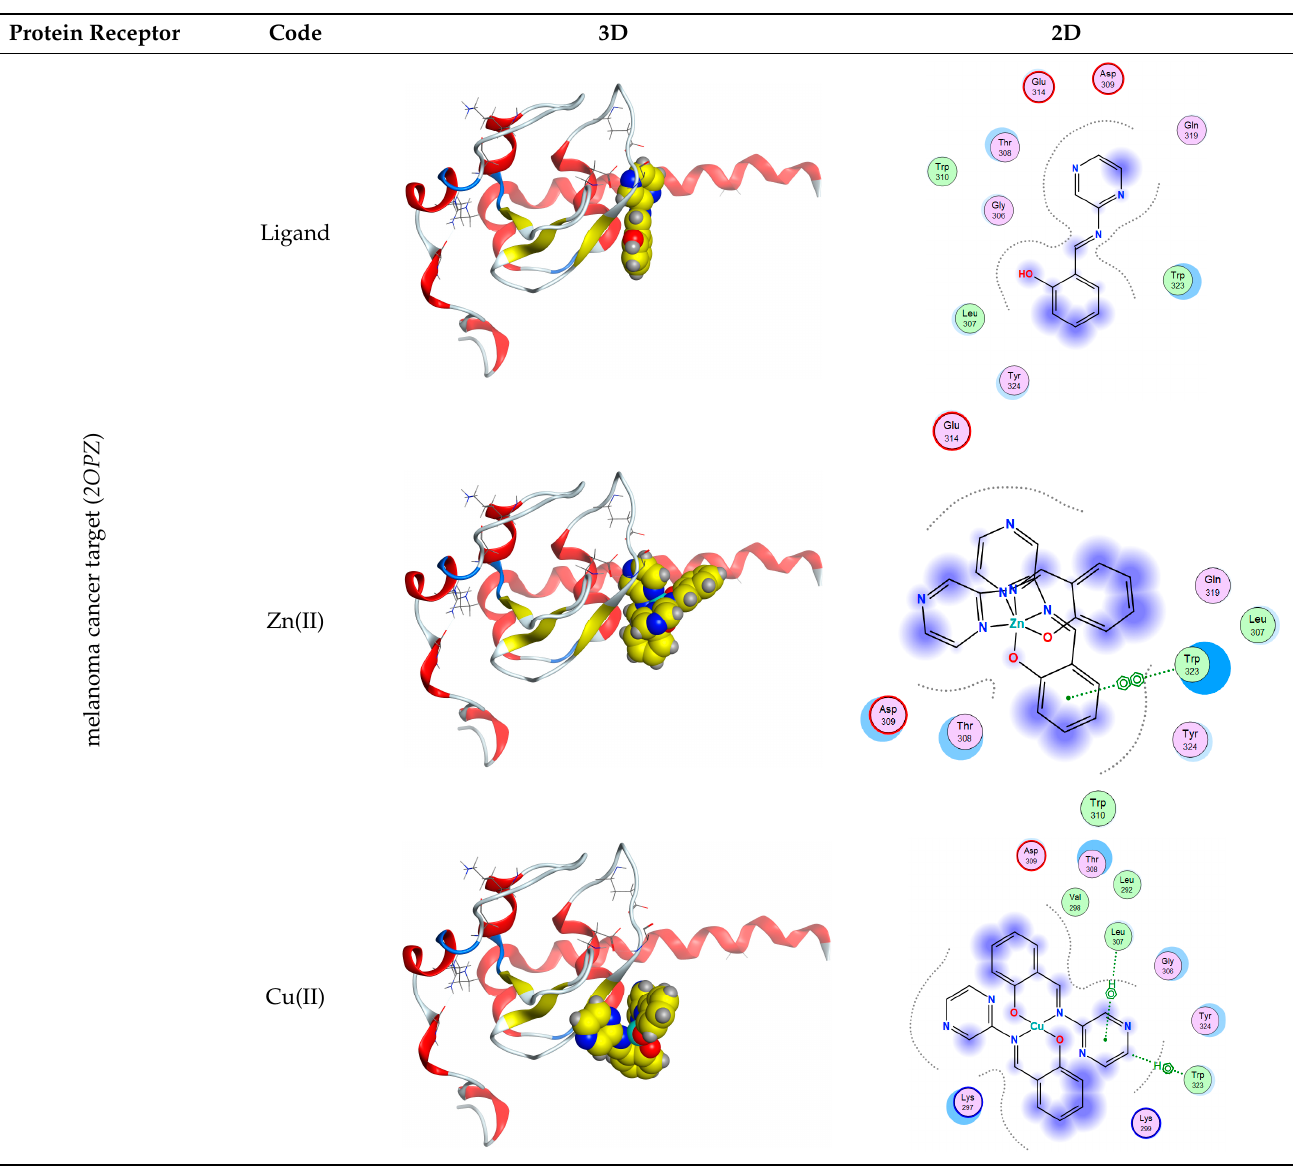
Table 5. The docking mode of the ligands and their metal complexes, 3D and 2D snapshot showing the hydrophilicity interaction to melanoma cancer target ( 2OPZ ) receptor, ovarian cancer target (3W2S) receptor and (NSCLC) cancer target (1S9J) receptor.